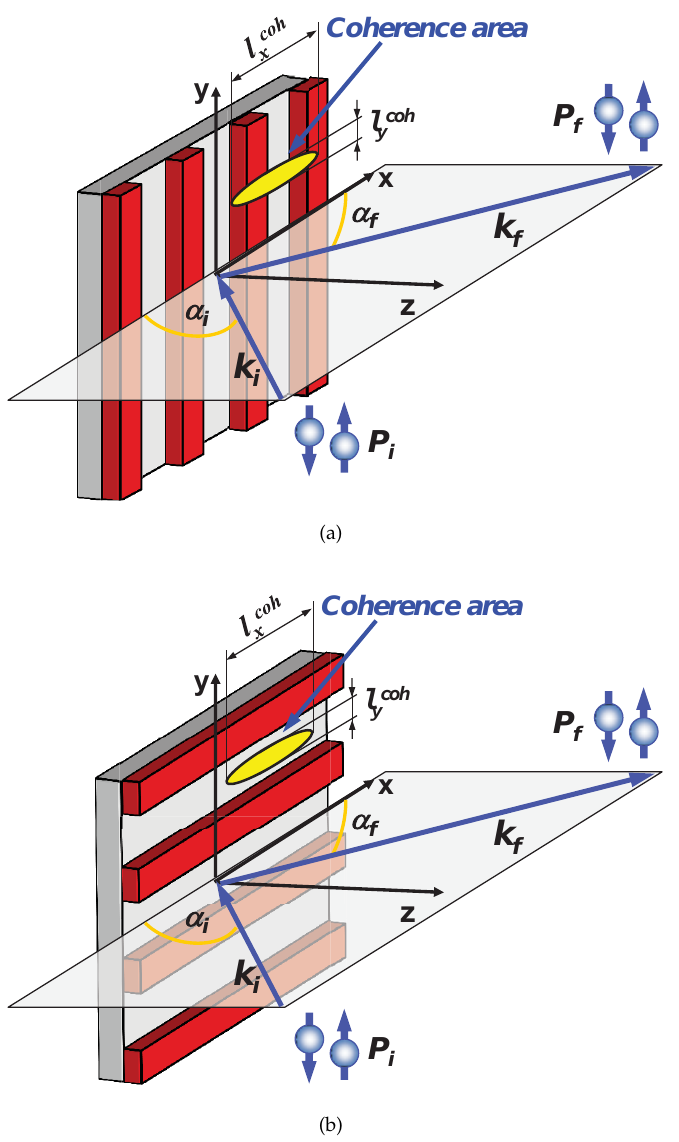
Figure 5. Mutual orientations of the coherence ellipsoid and the array of micro-stripes. ( a ) The coherence area crosses several stripes and off-specular Bragg diffraction can be observed. ( b ) The coherence area is collinear with the stripes, resulting solely in specular reflection, assuming flat edges and flat surfaces of the